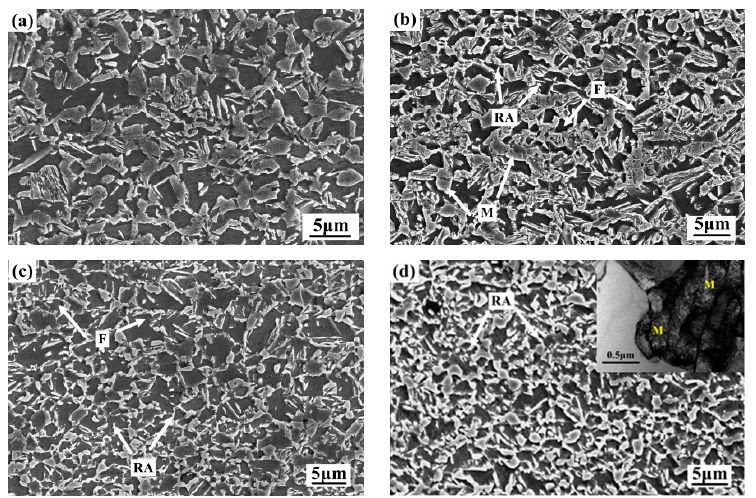
Figure 2. SEM micrographs of specimens at different partitioning temperatures: ( a ) 280 ◦ C, ( b ) 310 ◦ C, ( c ) 340 ◦ C, and ( d ) 370 ◦ C. Where RA is residual austenite, and M is martensite, and F is